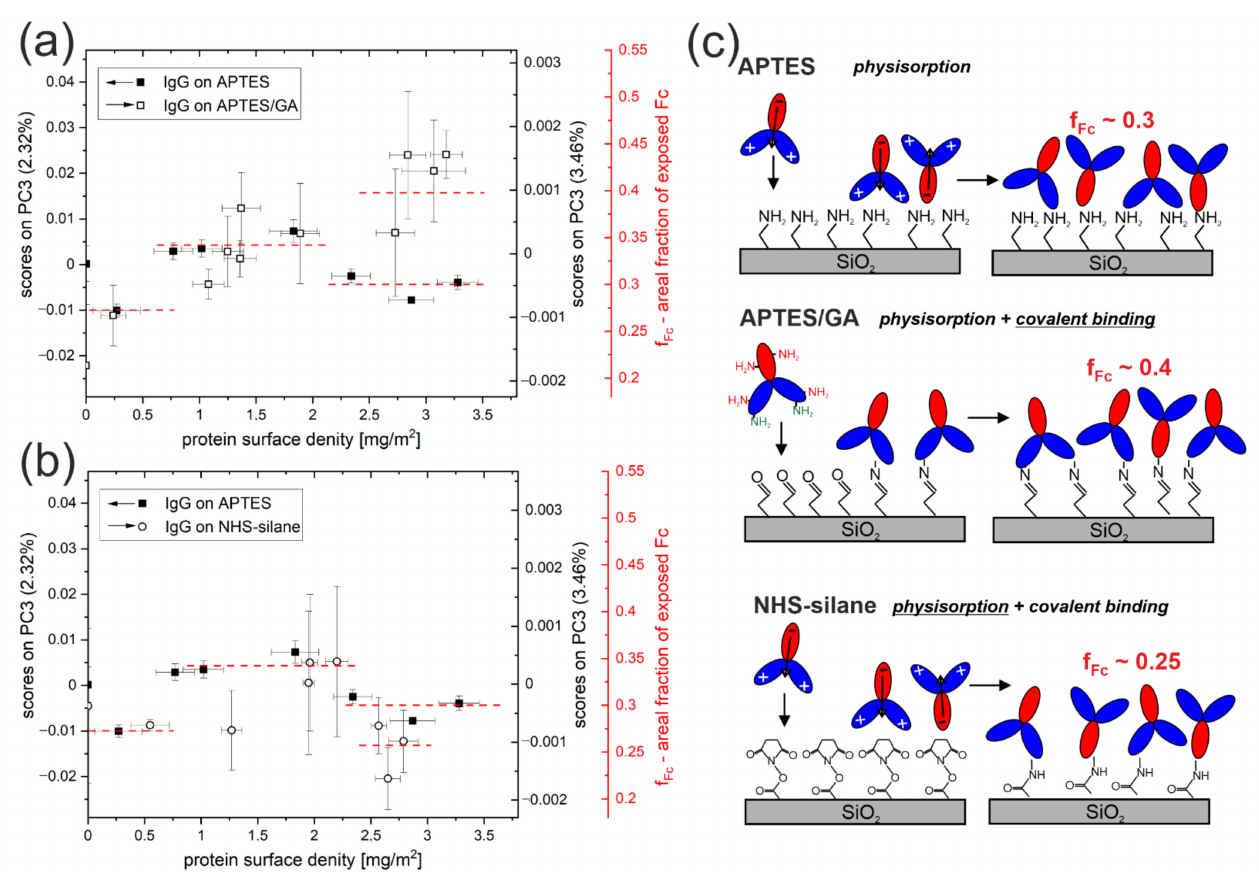
Figure 5. Comparison of the surface density-dependent orientation of IgG immobilized by physical adsorption on the APTES layer or by covalent coupling on the APTES/GA or NHS-silane layers [12]. Juxtaposition of the surface density dependence of the scores on the PC3 reflects changes in dominant IgG orientation for molecules physisorbed on APTES and covalently bound on APTES/GA ( a ) or NHS-silane modified surfaces ( b ). ( c ) Schematic presentation of the mechanism of immobilization of IgG molecules on examined silane layers by physical absorption or covalent attachment. Diagrams show the dominant IgG orientation revealed from TOF-SIMS studies for a high protein surface density corresponding to the vertical arrangement of molecules. The underlined terms mark the initial physisorption or covalent binding that is decisive for the final arrangement of